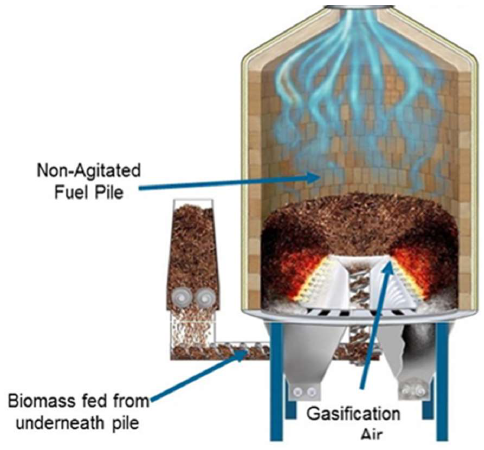
Figure 1. The updraft gasifier at the University of British Columbia, Vancouver campus.